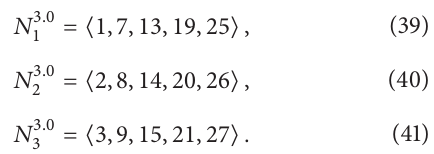
same level as the 𝑆 𝑖 label also correspond to an ordered set 𝑁